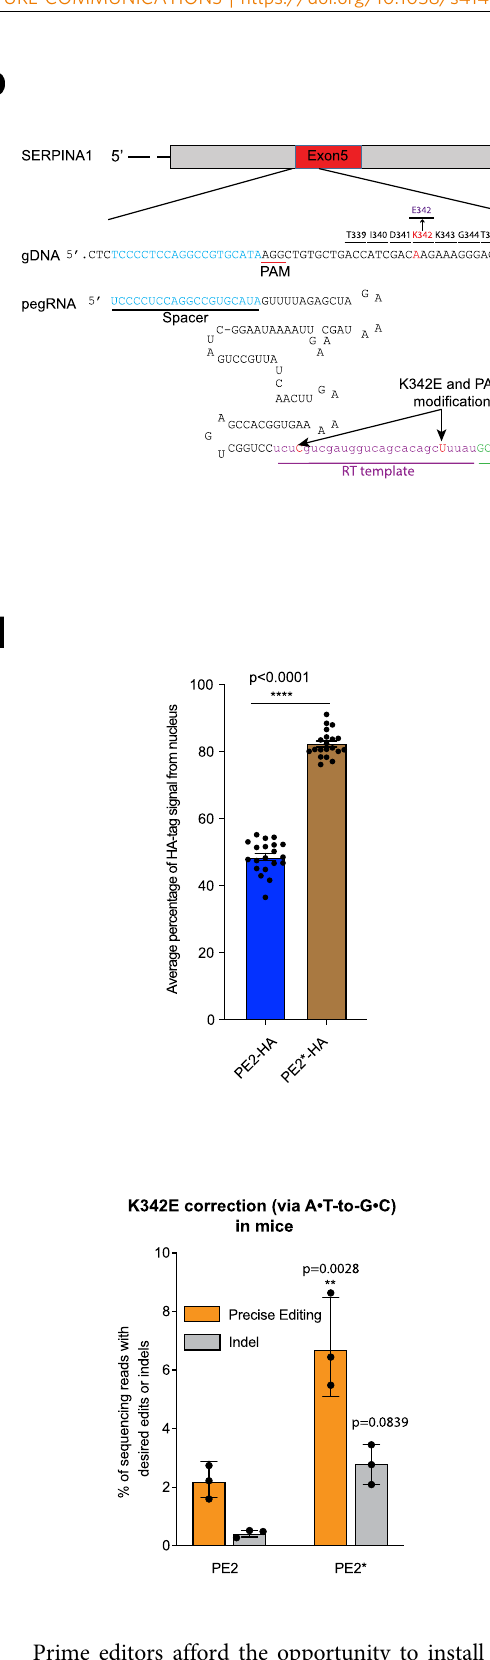
Prime editors afford the opportunity to install other types of mutations within the genome. To assess the feasibility of generating deletions in vivo, we designed a pegRNA to delete the S45 codon in Ctnnb1 , which is a previously described oncogenic mutation at this locus 34 (Fig. 4f). The prime